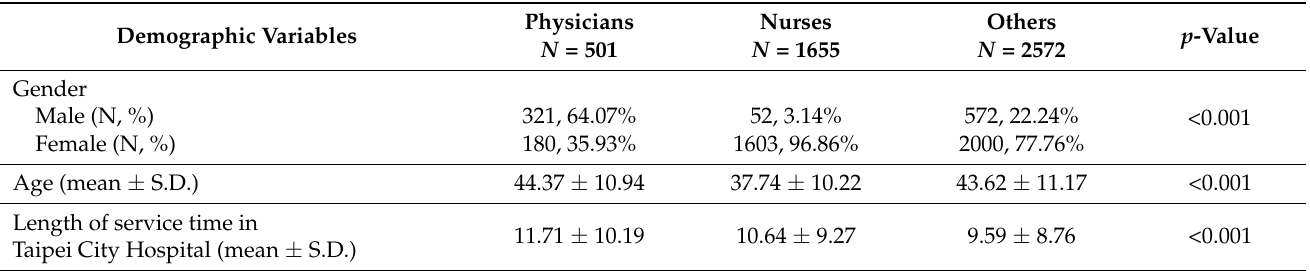
Table 2. Characteristics of the pre-test respondents ( N =